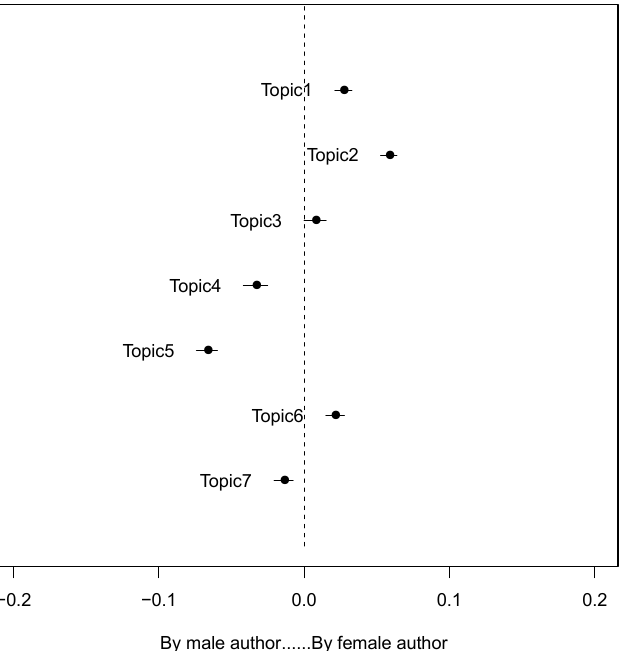
Figure 3. Association between topics and the gender of sex education discussants.